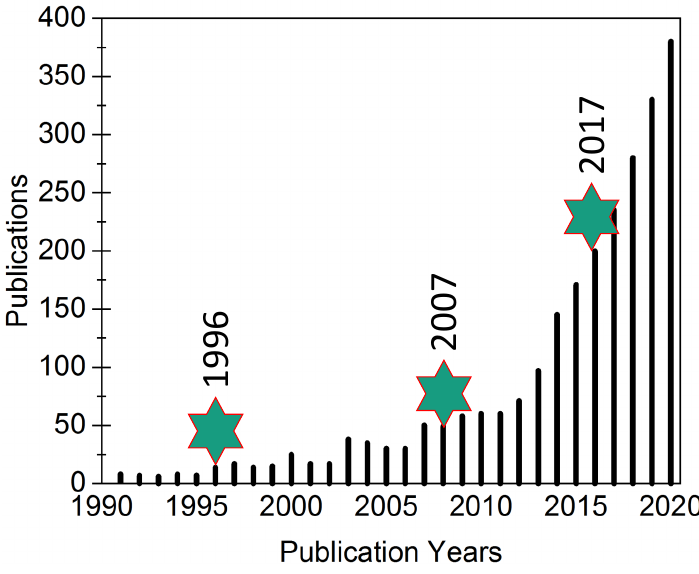
Figure 1. The number of publications on PersL materials as a function of the publication year. Three important years, 1996, 2007 and 2017, are also